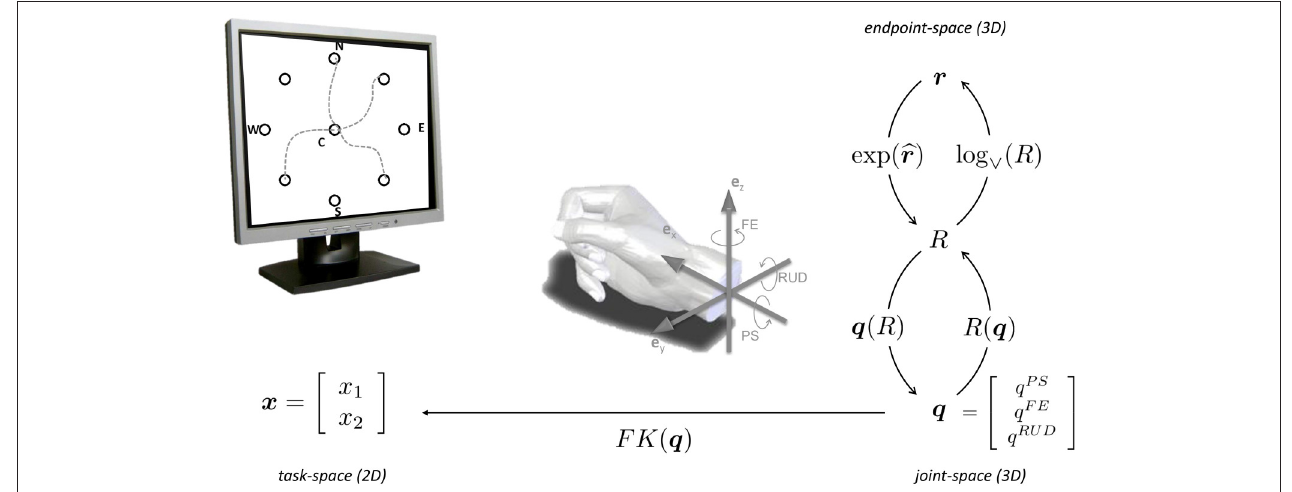
FIGURE 2 | Center-out task and kinematic spaces involved in wrist pointing. 3D wrist configurations can be equivalently expressed in terms of 3 × 3 rotation matrices R ( q ), rotation vectors r or joint rotations q . The forward kinematics x = FK ( q ) maps 3D wrist orientations onto the 2D task, expressed in screen coordinates x . Adapted from Campolo et al.